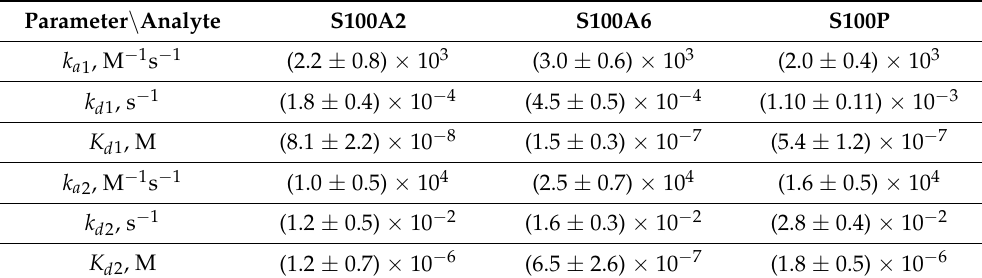
Table 1. The parameters of EPO-S100 interaction at 25 ◦ C, estimated from the SPR spectroscopy data (Figure 1) using the heterogeneous ligand model (1). k a and k d refer to kinetic association and dissociation constants, respectively; K d 1 and K d 2 are equilibrium dissociation constants: K d = k d / k a . The standard deviations are